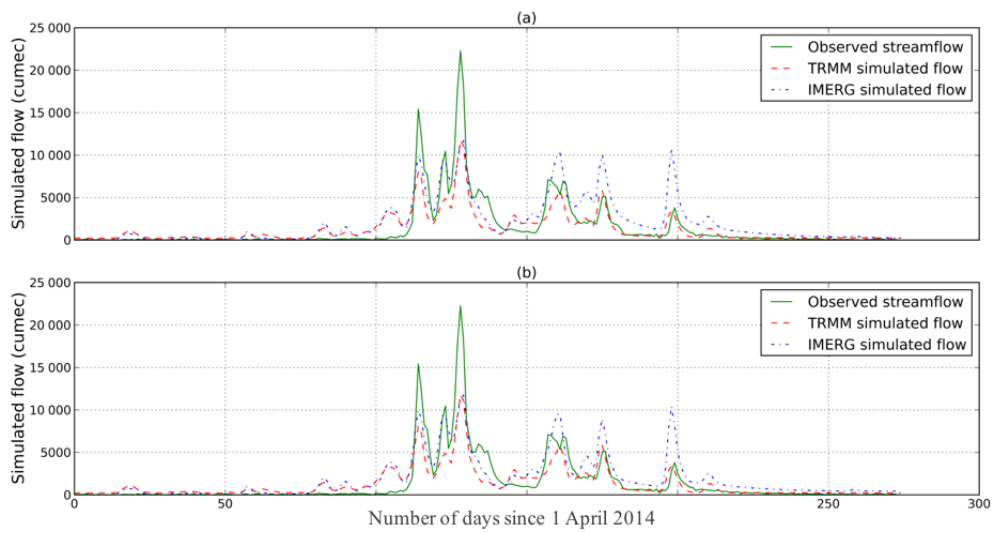
Figure 9. Hydrographs for TRMM and IMERG simulations (1 April–31 December 2014) with (a) IMD and (b) TRMM calibrated VIC model for the Hirakud basin.